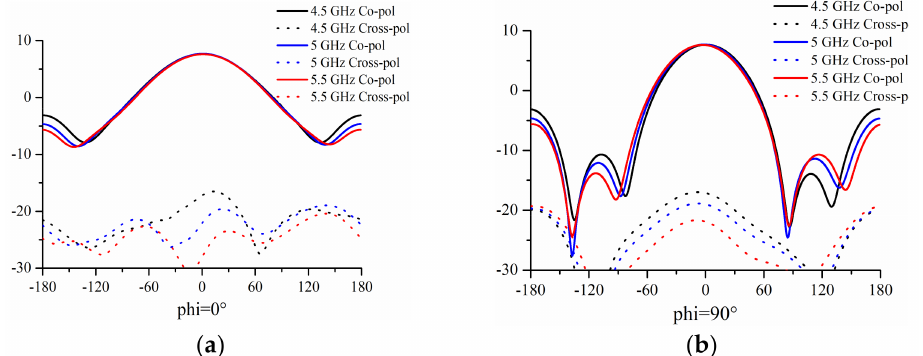
Figure 8. Measured 2D radiation patterns of Port 1: ( a ) at phi = 0 ◦ ; ( b ) at phi = 90 ◦ .